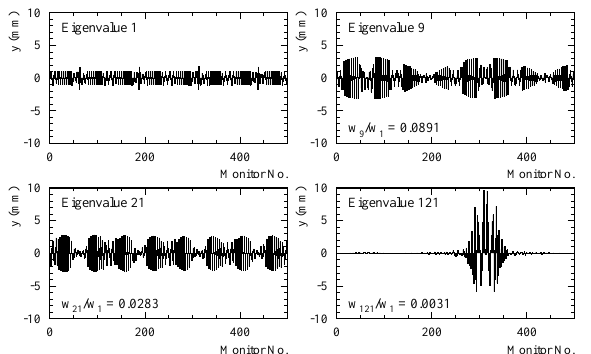
FIG. 3. Example of normalized orbit eigenvectors ( w 1 (cid:2) y (cid:1) i (cid:2) (cid:4) w i ) for the vertical plane at LEP with a (cid:1) 0.2 and b (cid:1) 0 . Only the orbit component of the eigenvector is shown here. The harmonic content of the first eigenvectors reflects the machine symmetries. The main harmonics are Q (the machine tune) for eigenvector 1, Q 6 1 for eigenvector 9, and Q 6 4 for eigenvector 21. The eigenvectors associated to small eigenvalues (bottom right) often correspond to long “bumps” over some section of the machine.